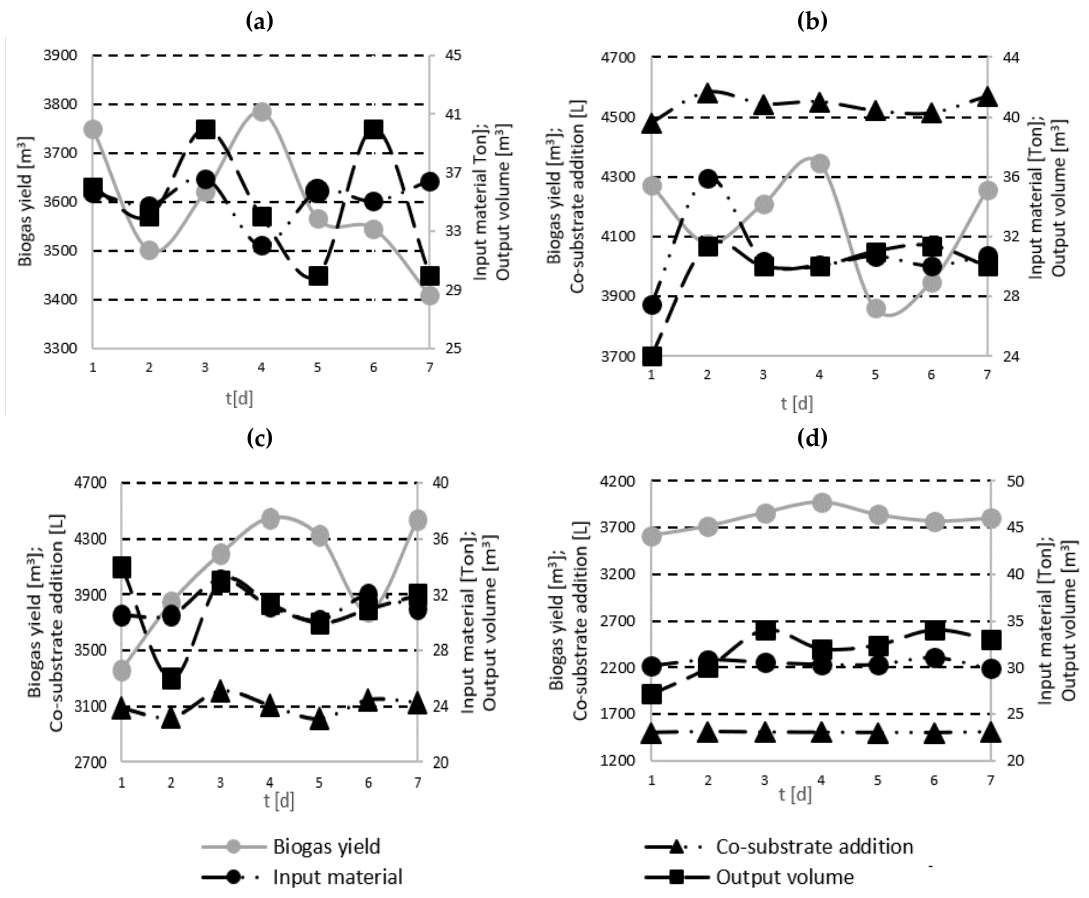
Figure 1. Parameter changes during 7-day anaerobic digestion runs: ( a ) OFMSW, ( b )OFMSW + 15% effluents from tanks cleaning, ( c ) OFMSW + 10% corn stillage, ( d ) OFMSW + 5% restaurant wastes.